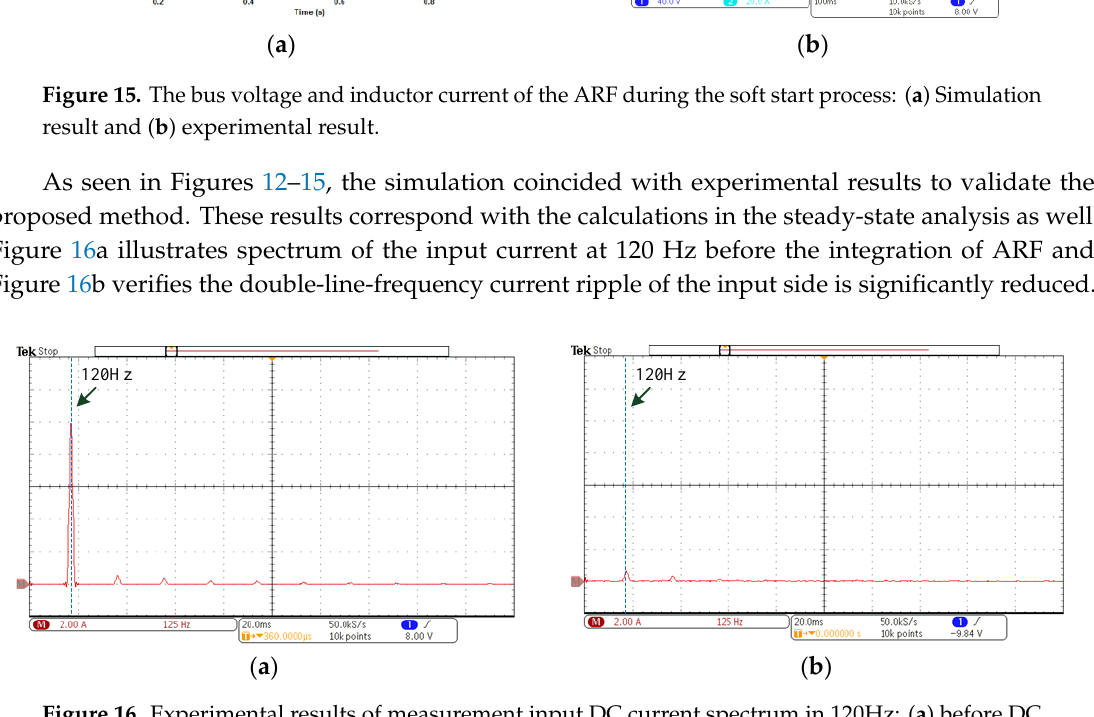
Figure 16. Experimental results of measurement input DC current spectrum in 120Hz: ( a ) before DC energy source integrates with ARF and ( b ) DC energy source integrates with ARF.